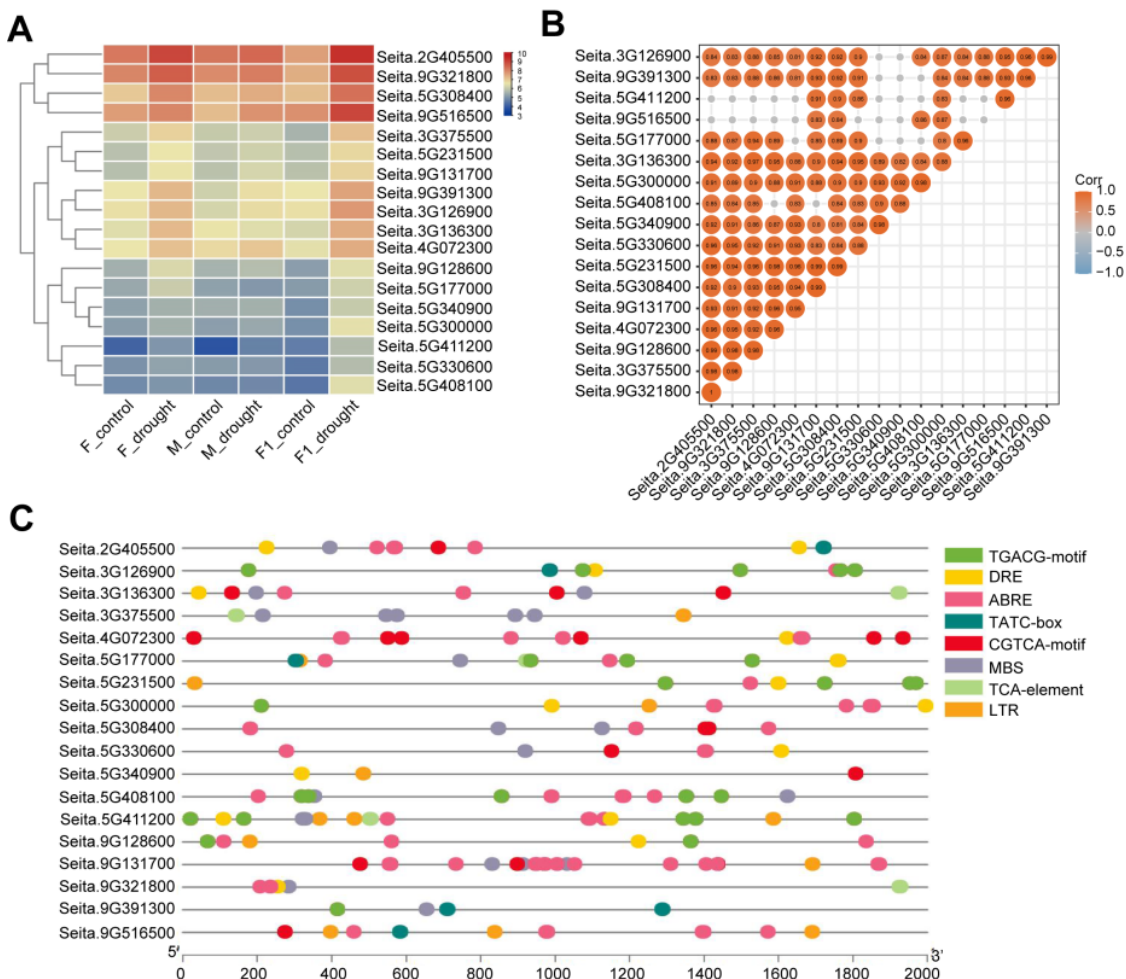
Figure 3. Analysis of drought resistance and heterotic genes. ( A ) Expression patterns of 18 candidate genes. ( B ) Correlation analysis of the candidate genes. ( C ) Promoter cis-regulatory element analysis of the candidate genes.